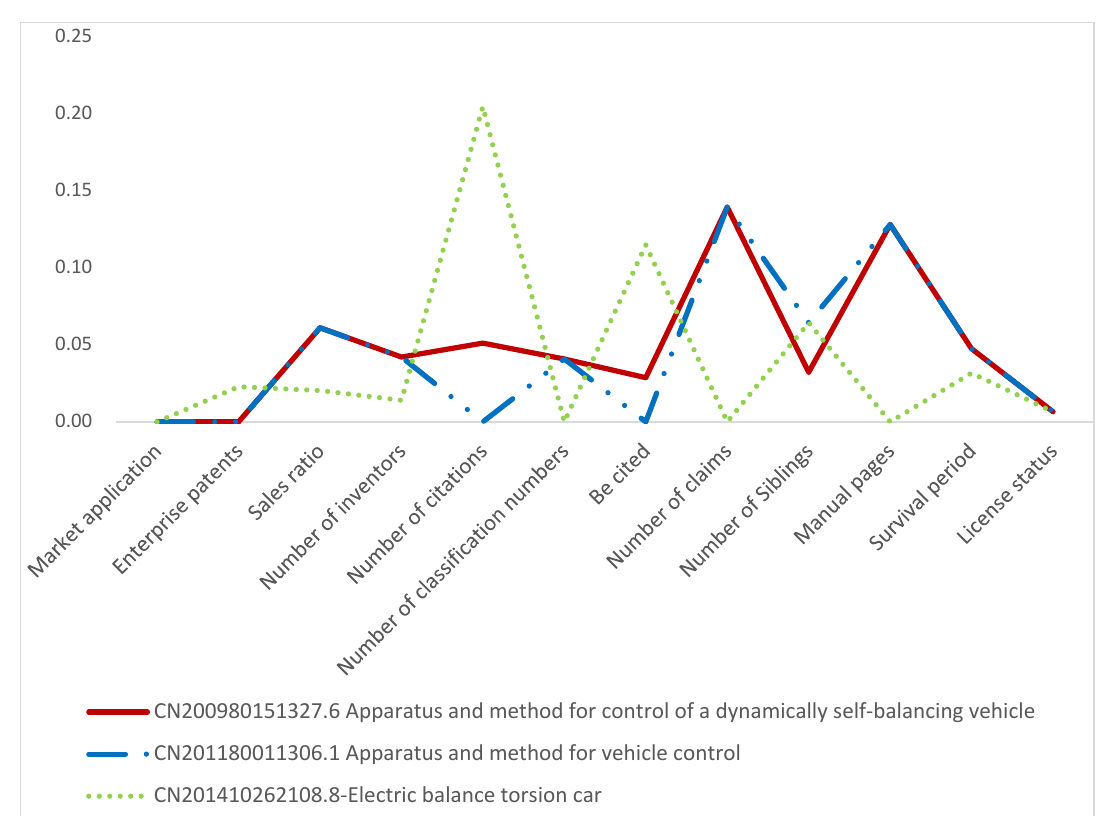
Figure 6. Line chart of the top three patent attribute scores.